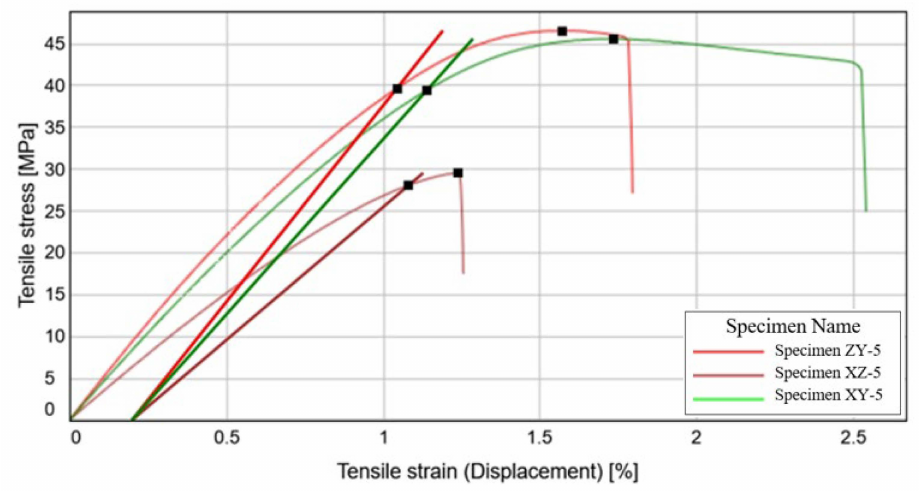
Figure 17. Stress-Strain curve variation for each 3D printed specimen